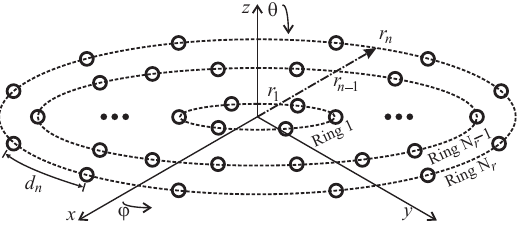
Figure 1. General layout of a concentric circular ring array